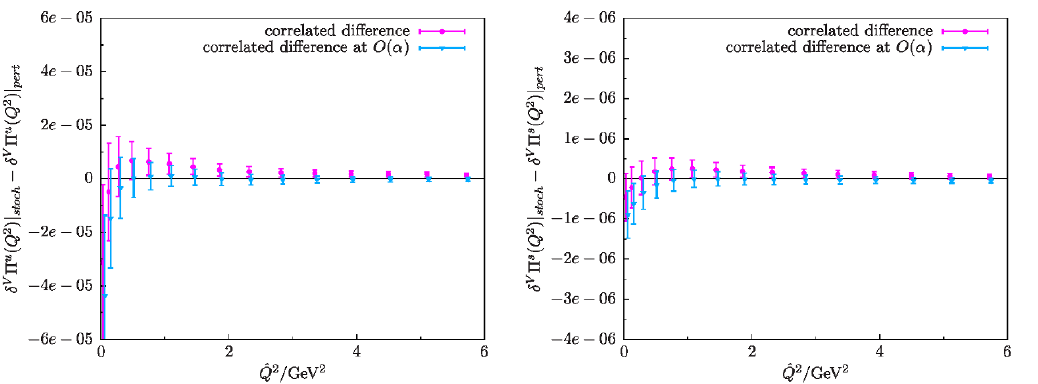
Figure 19 . Di(cid:11)erence between the QED correction to the HVP from stochastic and perturbative method. Purple circles show results using the data from the computation at the physical value of the coupling (cid:11) for the stochastic method. Light blue triangles are using only the O ( (cid:11) ) correction from the stochastic